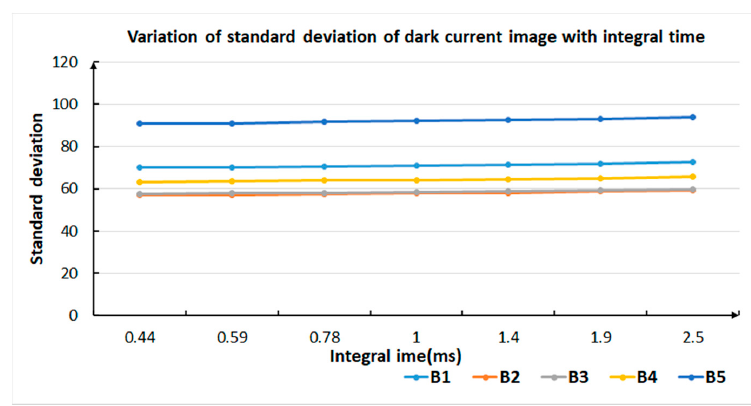
Figure 9. Variation in the standard deviation of the dark current image with integration time (0.44–2.5 ms).